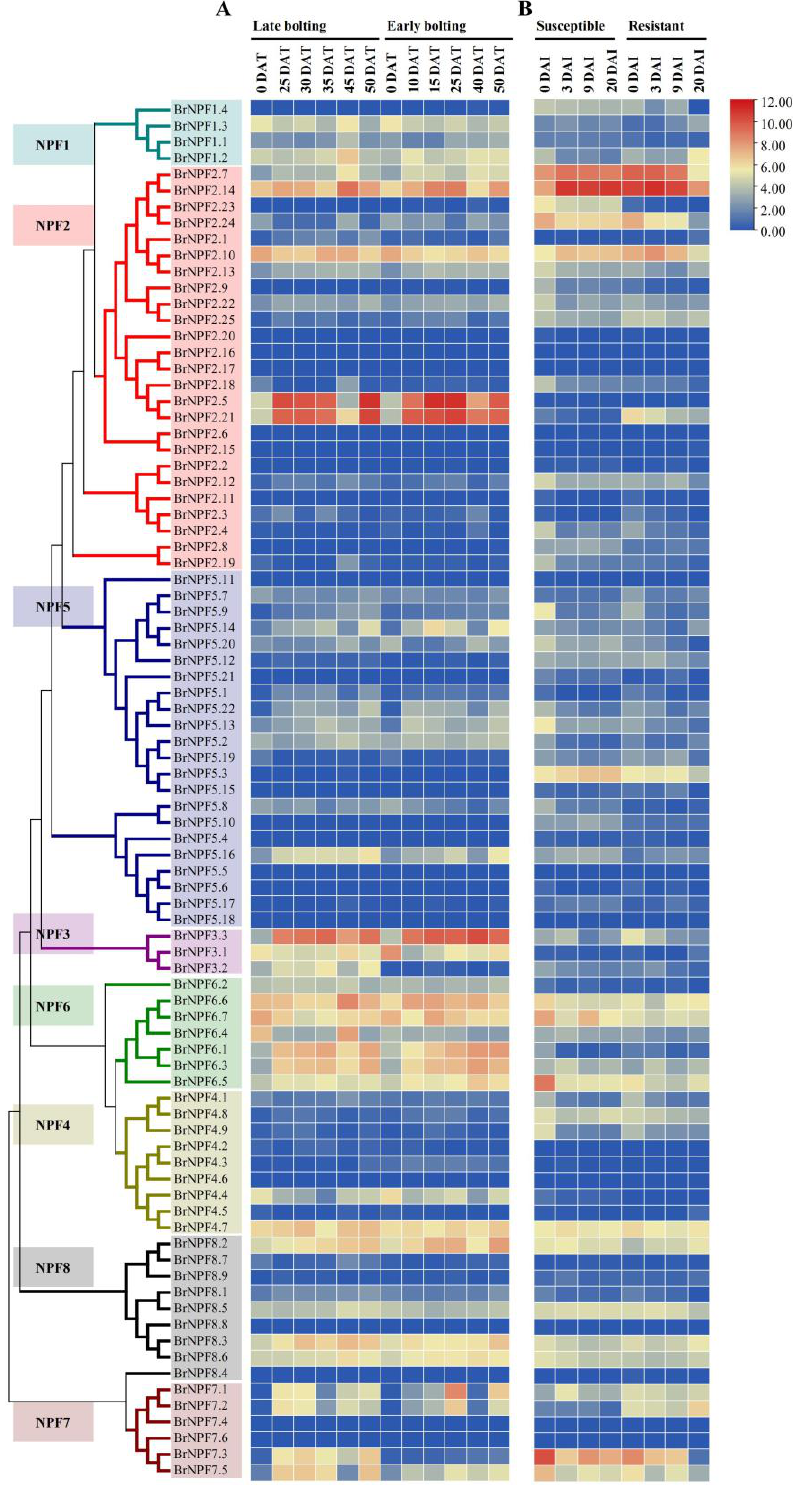
Figure 6. Expression patterns of BrNPFs responsive to vernalization ( A ) and P. brassicae infection stress ( B ). DAT, day after treatment. DAI, the day after inoculation.